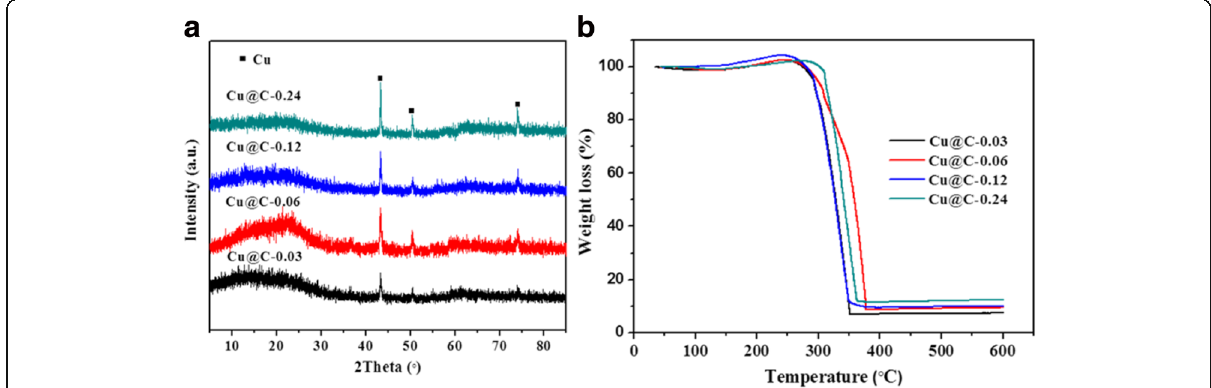
Fig. 5 a XRD patterns and b TG curves of samples: Cu@C-0.24, Cu@C-0.12, Cu@C-0.06,